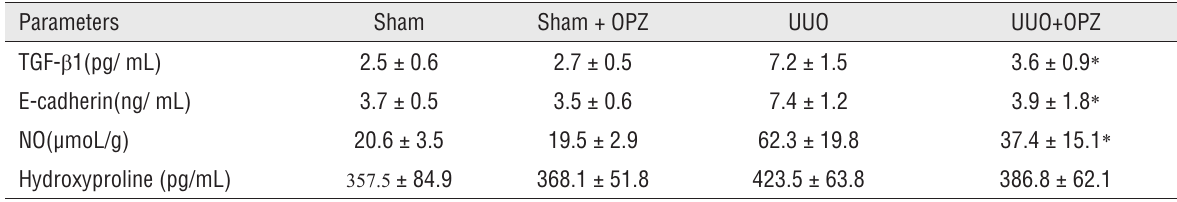
Table 1 - TGF- β 1, E-cadherin, NO and Hydroxyproline levels in kidney.